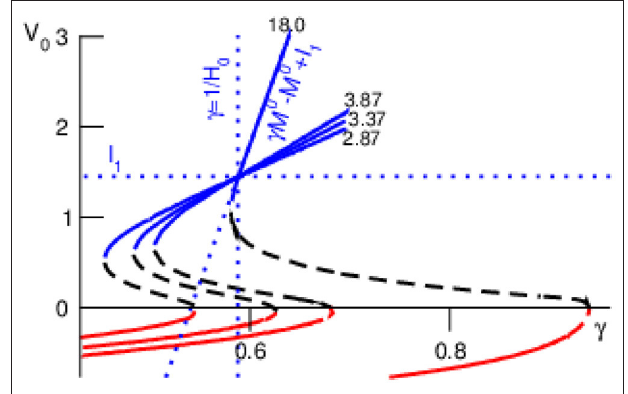
FIGURE 3 | Equilibria of ¯ V 0 and their stability for various values of M 0 (numbers in plot). Other parameter values are taken from Figure 2